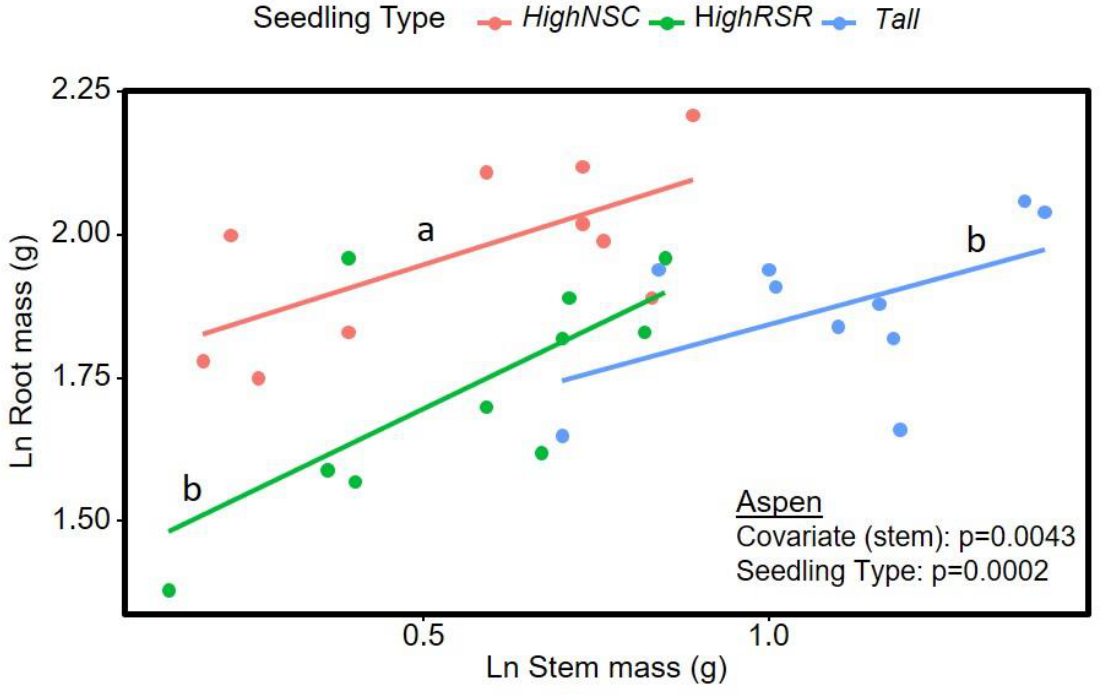
Figure A4. Allometric relationships between final root and stem Biomass Total for aspen seedling types under well-watered conditions (control). Lines represent individual linear regressions for each treatment and seedling type combination. Differences between seedling types were tested using ANCOVA, after testing for homogeneity of slopes. Different letters represent significant differences in intercepts between seedling types according to Tukey’s HSD (all p < 0.005).